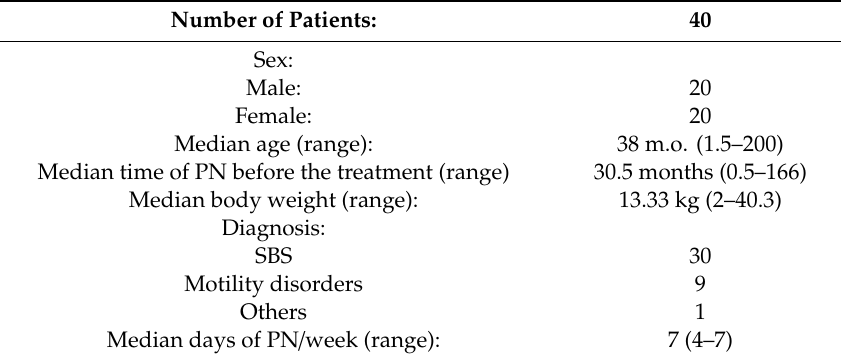
Table 3. The characteristics of studied group of patients at the onset of